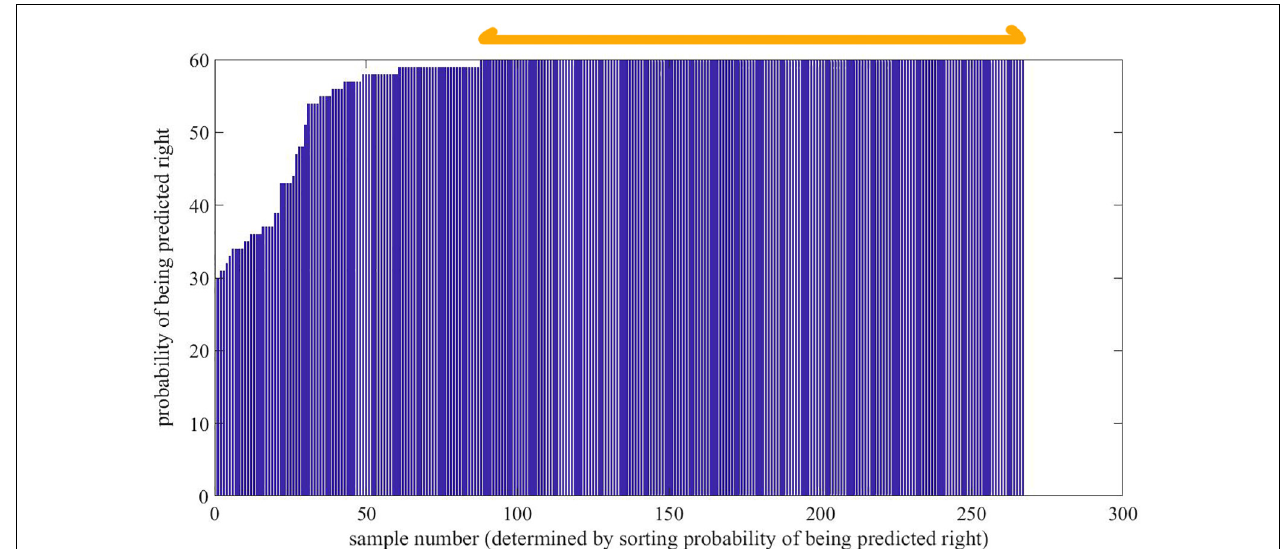
FIGURE 6 | Mean prediction accuracy on test set for special partition and random partition.